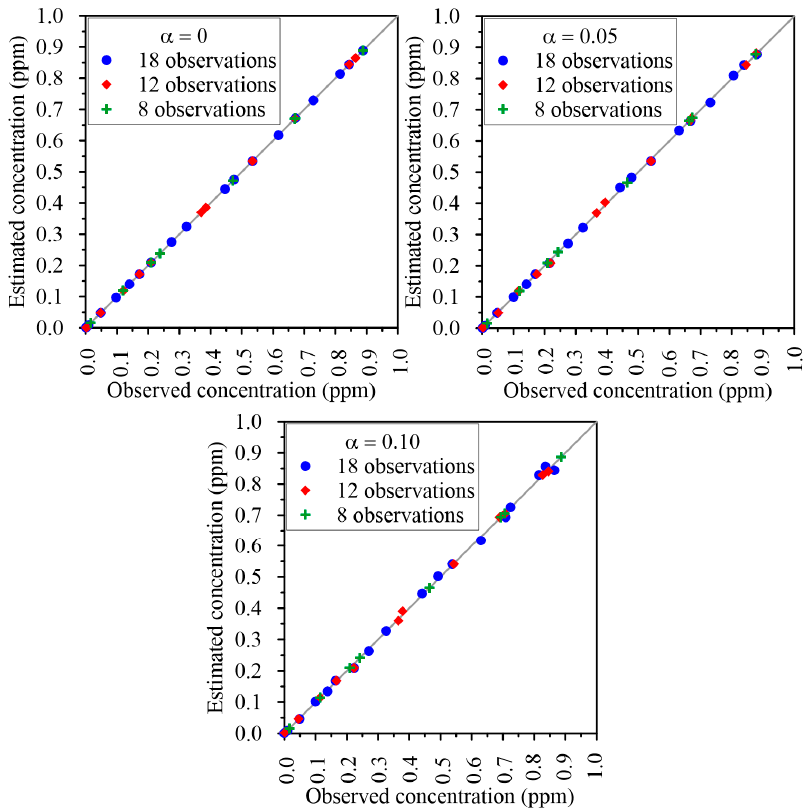
Figure 17. Estimated vs. observed concentration in the various scenarios.